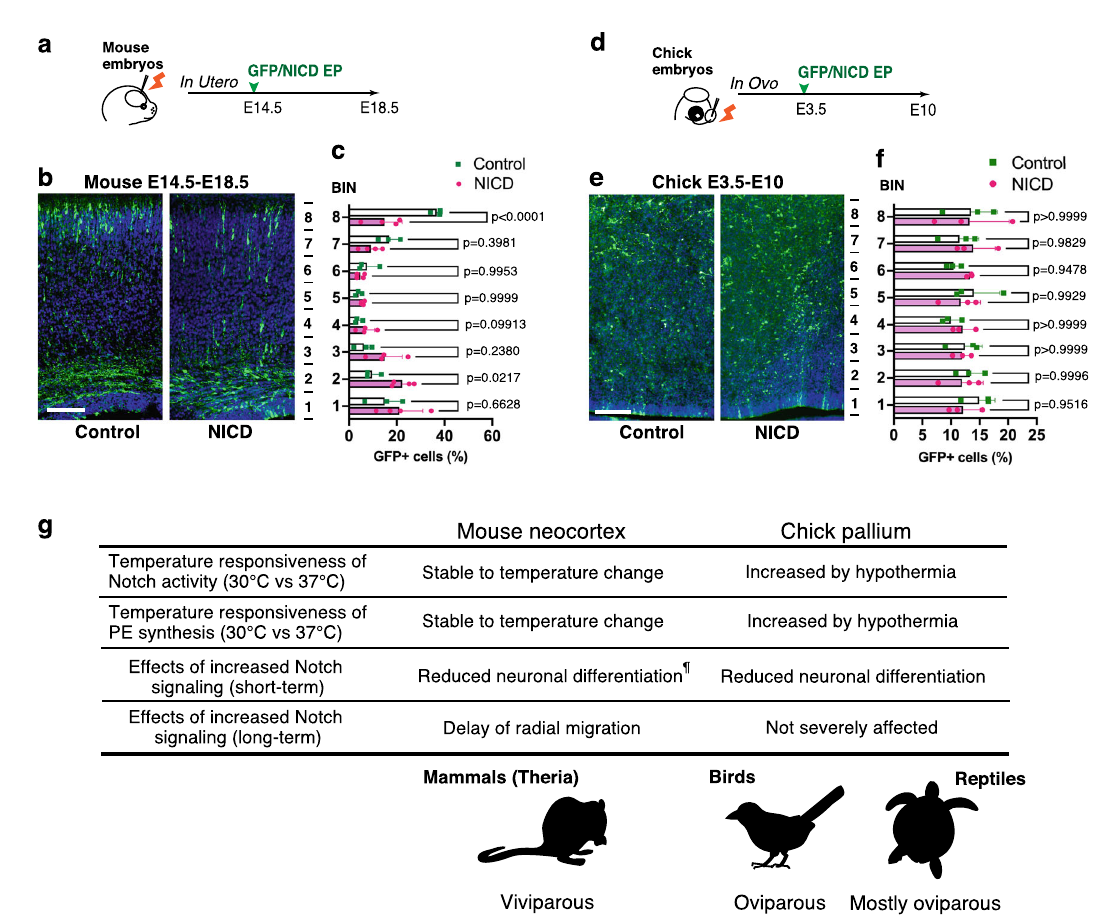
Fig. 6 Species-speci fi c susceptibility to altered Notch signaling in amniote pallium. a – f Transient NICD overexpression in the developing mouse neocortex ( a – c ) and chick pallium ( d – f ) by in utero or in ovo electroporation. a Schematic illustration of in utero electroporation. b , c Distribution of GFP- positive neurons in the developing mouse neocortex electroporated with the control or NICD expression vector (mean + SD, n = 3 biologically independent samples in each group). d Schematic illustration of the in ovo electroporation experiment. e , f Distribution of GFP-positive neurons in the developing chick dorsal pallium electroporated with control or NICD expression vector (mean + SD, n = 3 biologically independent samples in each group). g Summary of the species-speci fi c temperature responsiveness of Notch signaling, PE synthesis, and the effects of increased Notch signaling in the developing amniote pallium ( ¶ Refs. 16,38 ). Two-way ANOVA for c , f ( p -values were adjusted by Tukey test). Scale bars: 100 µ